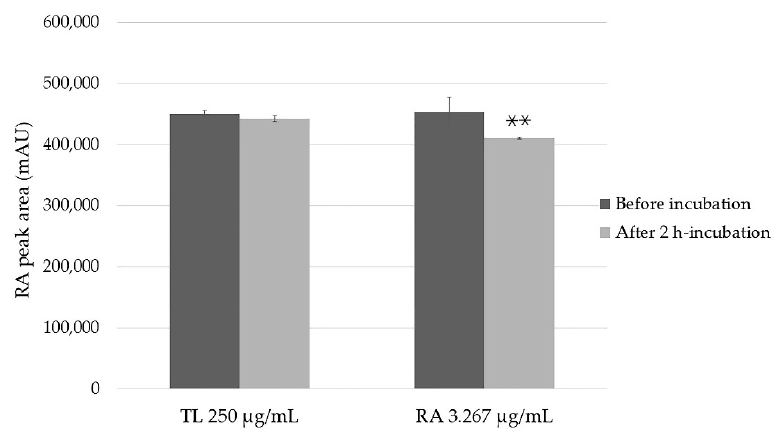
Figure 2. The stability of RA in TL extract and pure compound in HBSS (pH 7.4) before and after incubation at 37 °C for 2 h. The data represent the mean ± SD from three replicates . ** was signifi ‐ cantly different from RA in TL extract at 250 μ g/mL ( p <